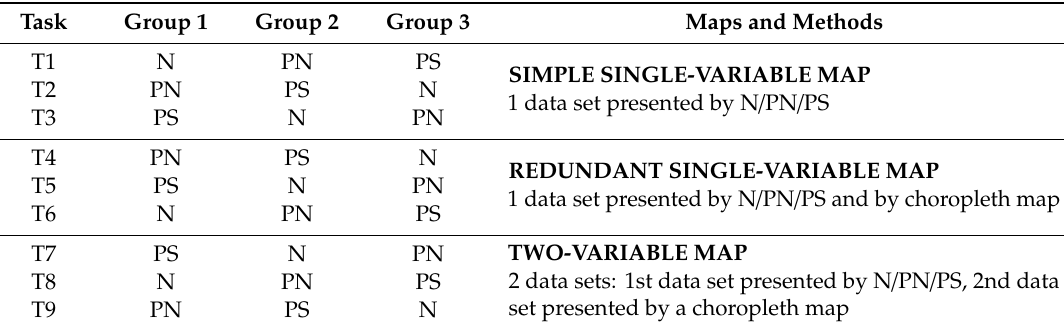
Table 1. Study design. Each user solved nine tasks, three from each set of tasks. Task Maps and Methods